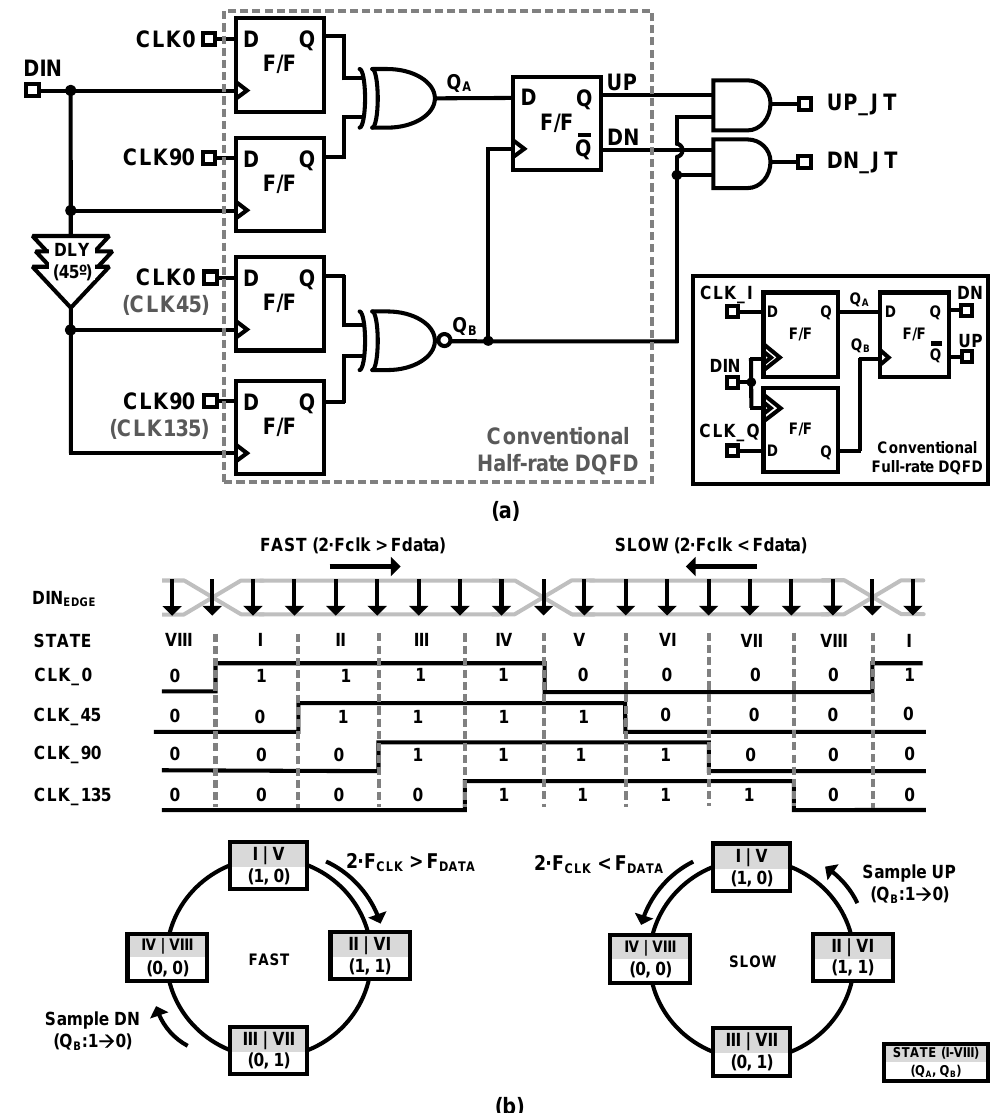
Figure 3. ( a ) The schematic of the proposed jitter-tolerant DQFD circuit and the conventional half-rate DQFD ( b ) the state model and state diagram of the conventional half-rate